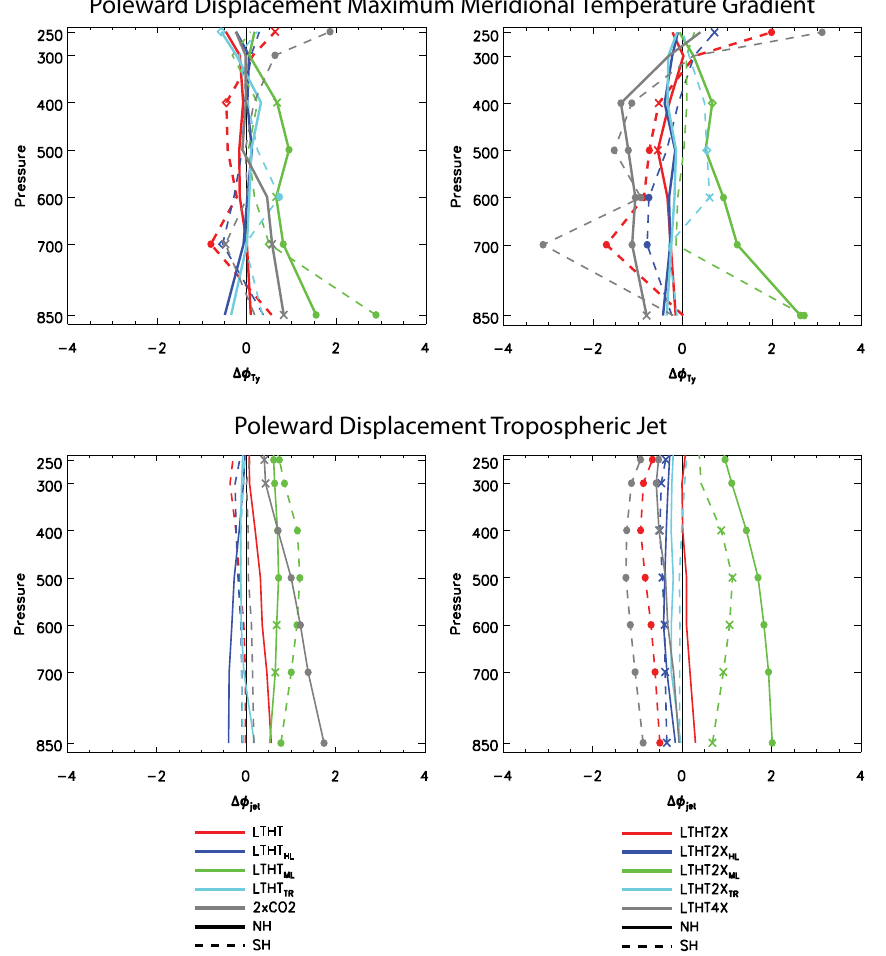
Fig. 4. Poleward displacement of the (top) latitude of the maximum tropospheric temperature gradient ( T y ) and (bottom) jet for the Northern (solid) and Southern (dashed) Hemisphere for various LTHT and 2 × CO2 experiments. Symbols represent significance at the 90% (diamond); 95% (cross) and 99% (dot) confidence